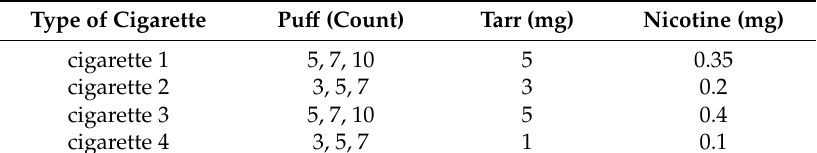
Figure 1. Rotary smoking machines ( a ) RM200A2 of BORGWALDT ( b ) Operation of Smoking Machine RM200A2 (in Seoul, Korea).